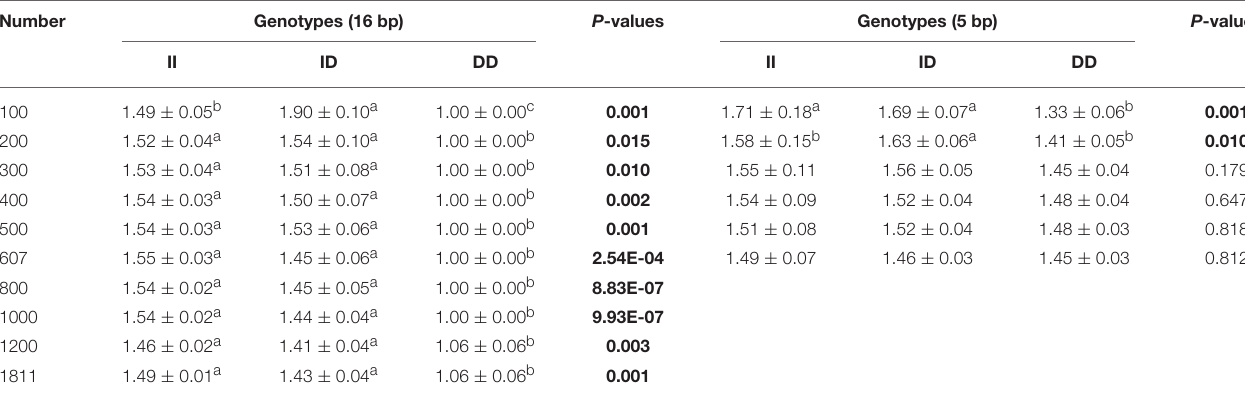
TABLE 4 | Associations of the 16 and 5 bp loci with first-born litter size in detected groups with different numbers. Number Genotypes (16 bp) P -values Genotypes (5 bp) P